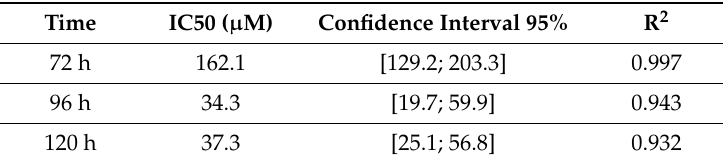
Table 1. Median inhibitory concentration of the cultures (IC50) values of human fibroblast primary cultures submitted to ZOL for 72 h, 96 h and 120 h, the respective confidence interval at 95%, and the determination coefficient of the curves.